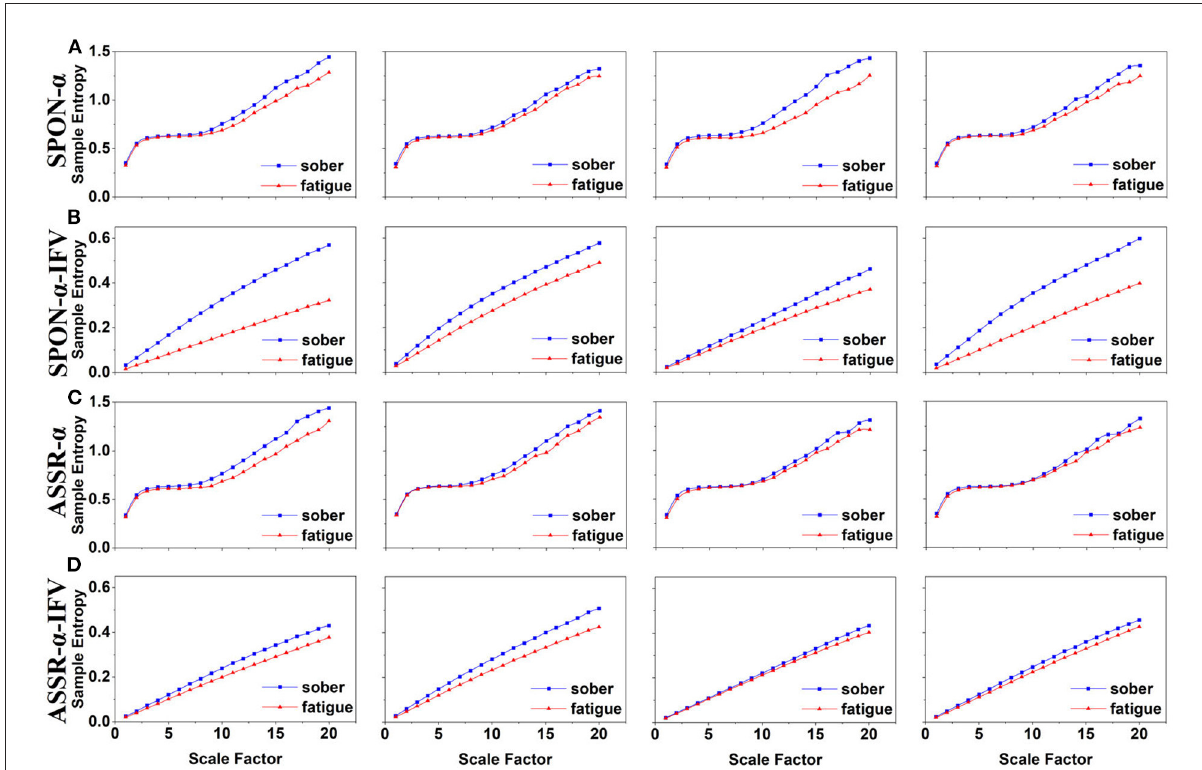
FIGURE3 MSE analysis of SPON- α (A) , ASSR- α (B) , SPON- α -IFV (C) , and ASSR- α -IFV (D) on parietal lobe (channel P4) from four exemplary subjects. The blue and red lines represent the Sober and MF states, respectively. See Section 2.5 for the definitions of